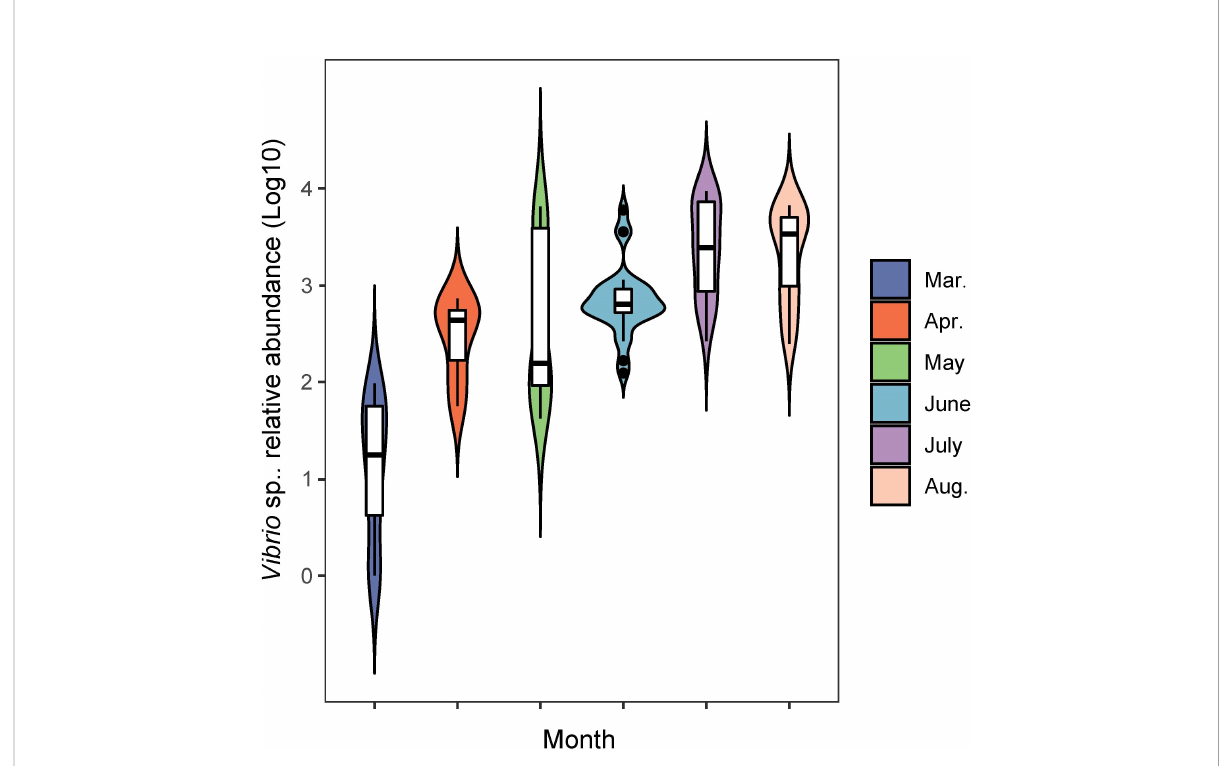
FIGURE 5 The monthly variation of Vibrio abundance in shell fi sh farming areas.